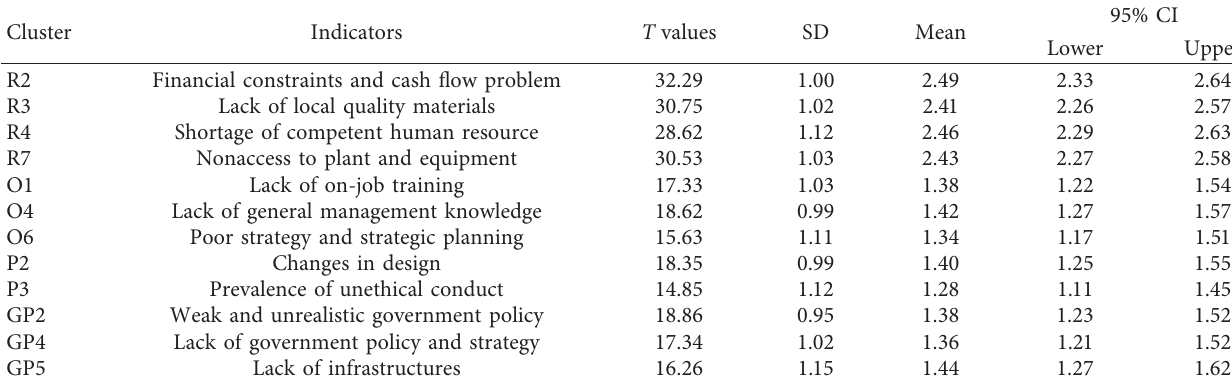
Figure 3: Respondent’s opinion on performance measurement. A � increased number of employees; B � quality increases; C � attain value for money; D � increased social performance; E � increased return on investment and asset (ROI & ROA); F � employee’s salary increase; G � new technology adoption; H � timely project completion; I � environmental sustainability; J � employee’s economic growth; K � profitability. Table 7: Performance weaknesses indicators.